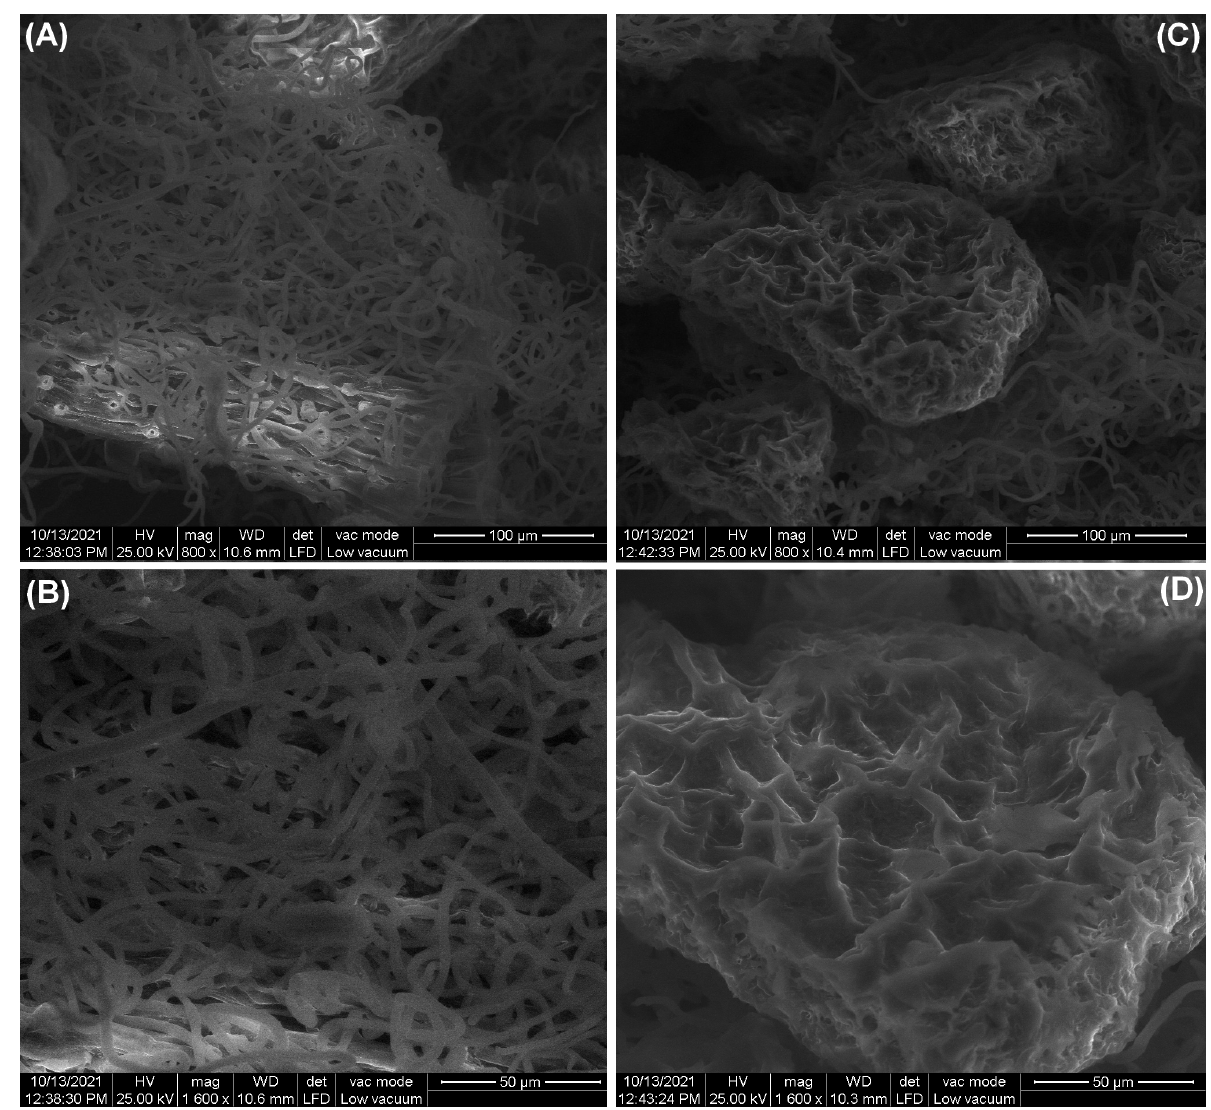
Figure 3. SEM images of adsorbent material surface before adsorption ( A , B ) and after adsorption ( C , D ) at different magnification.